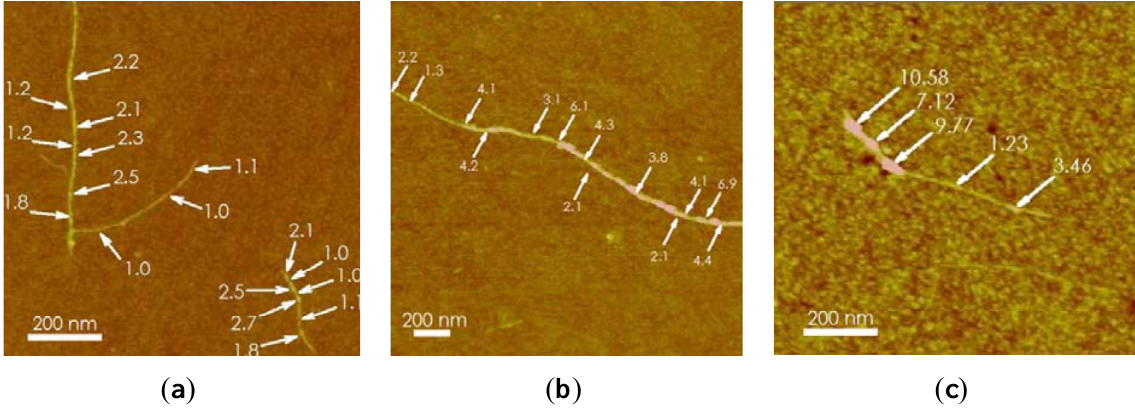
Figure 2. Atomic force microscopy of SWCNT complexed to ( a ) siRNA; ( b ) siRNA followed by l -PEG-5000; ( c ) siRNA followed by exposure to 1% bovine serum albumin (BSA). Diameters: SWCNT ~1 nm; siRNA coated ~1 to 3 nm; linear ( l ) or branched ( br )-PEG 5000 coating ~4 to 6 nm; BSA ~7 to 10 nm.